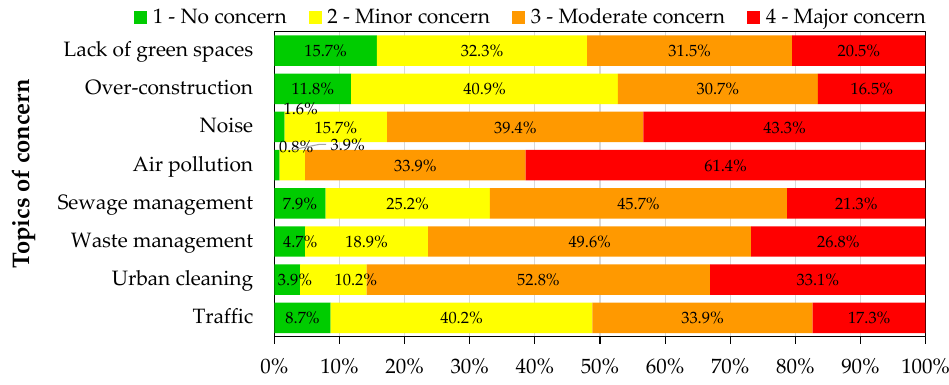
Figure 3. Level of concern of the UFSAAPP population regarding different environmental topics. For the general population, the environmental topics that gather the highest levels of concern are urban cleaning (31.5%) and waste management (31.2%), followed in third po- sition by air pollution (27.4%). This rank changes greatly when focusing on the UFSAAPP population, where air pollution gathers the highest level of concern (61.4%), followed by noise (43.3%) and then, urban cleaning (33.1%).